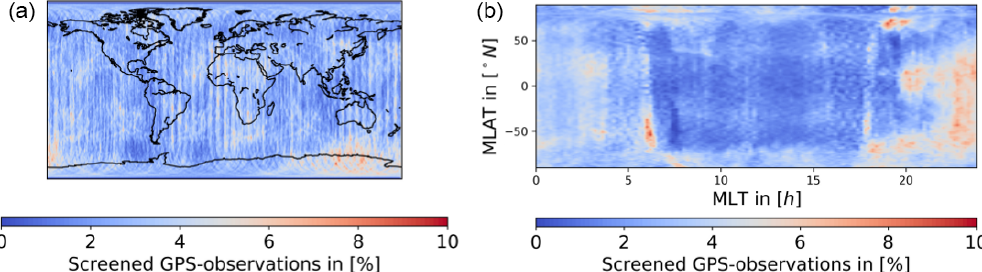
Figure 5. Average number of GPS observations screened in the preprocessing for the analyzed test period, 2015: January, March; 2016: February, March, June, July, August. (a) Geographic coordinates; (b) magnetic coordinates.